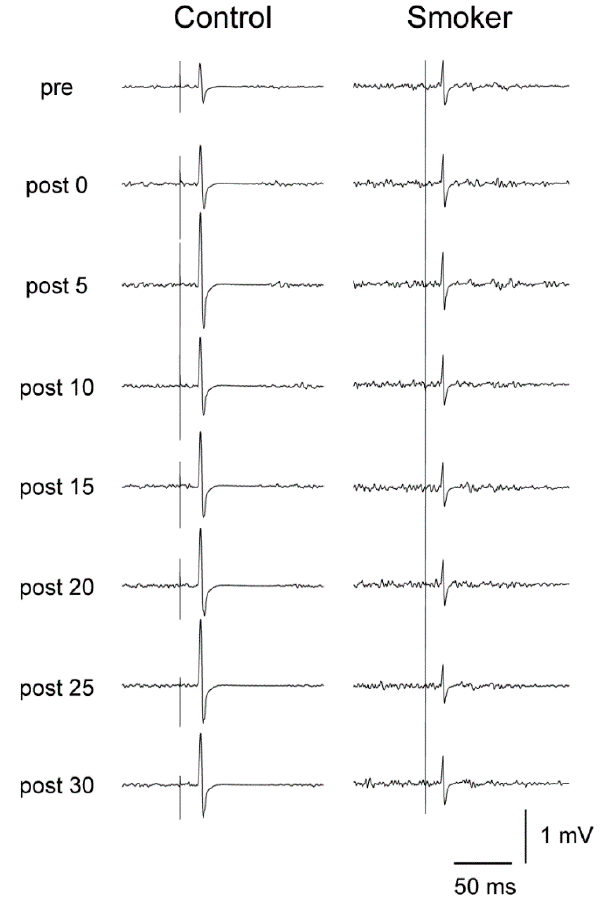
Figure 2. Comparison of effect of paired associative stimulation (PAS) on peak-to-peak motor-evoked potential (MEP) showing an example of raw data from one non-smoker control subject in the left-hand column and one smoker in the right-hand column.